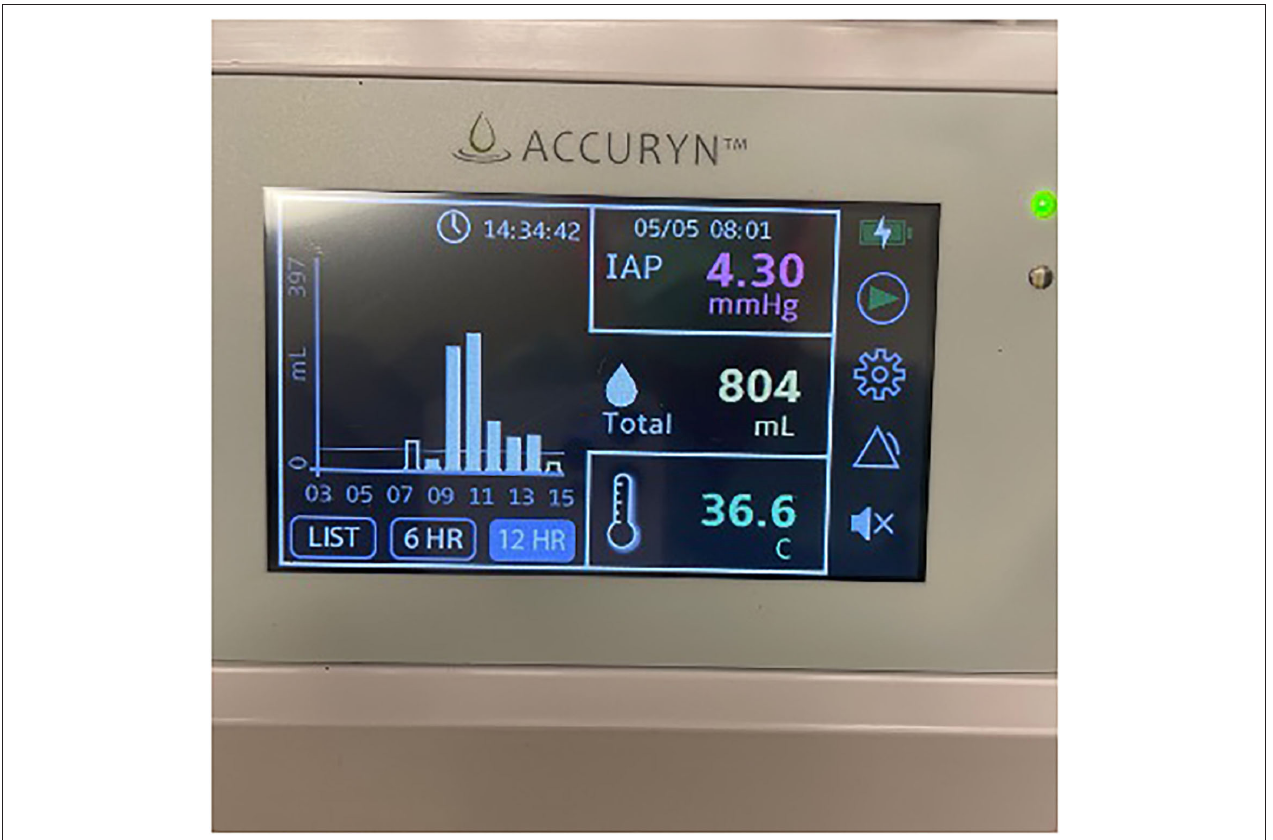
FIGURE 1 | Photo of the Accuryn Monitoring System’s display showing urine output, temperature, and intra-abdominal pressure. (Note that this picture was not taken during the patient’s surgery. It serves as an example of this monitoring system).